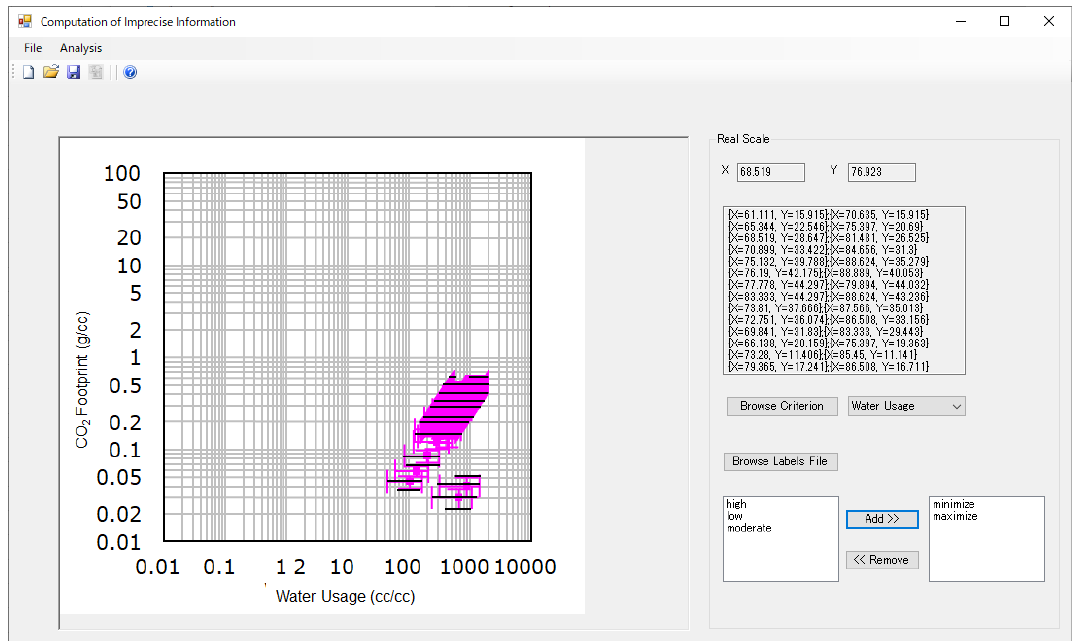
Figure 8. User interface of the decision tool for extracting ranges representing the water usage of wooden materials.